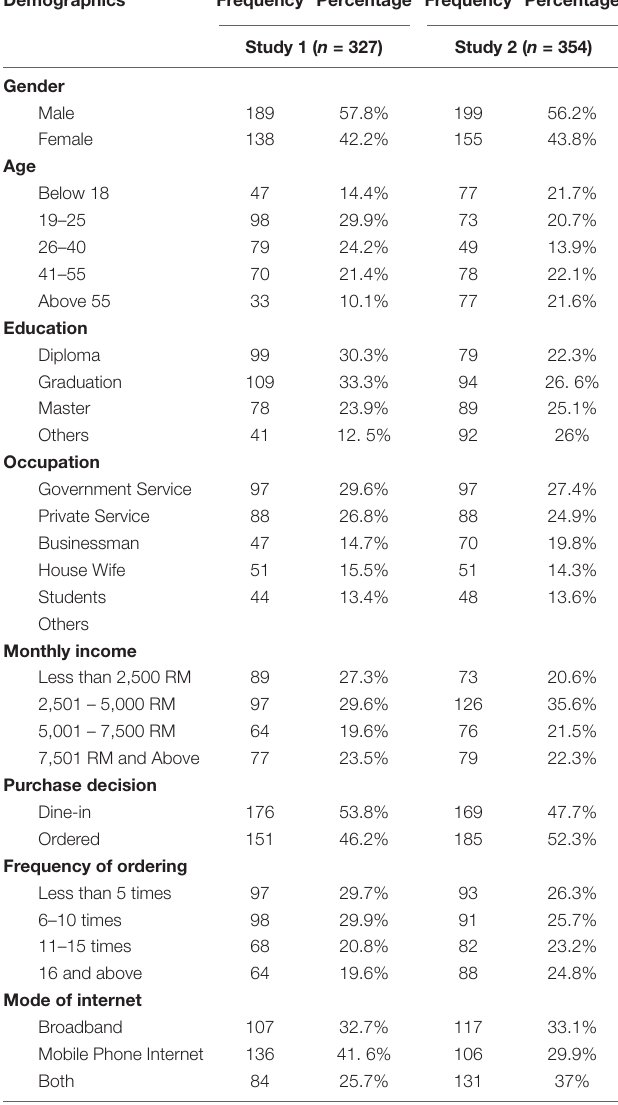
TABLE 3 | Respondent’s